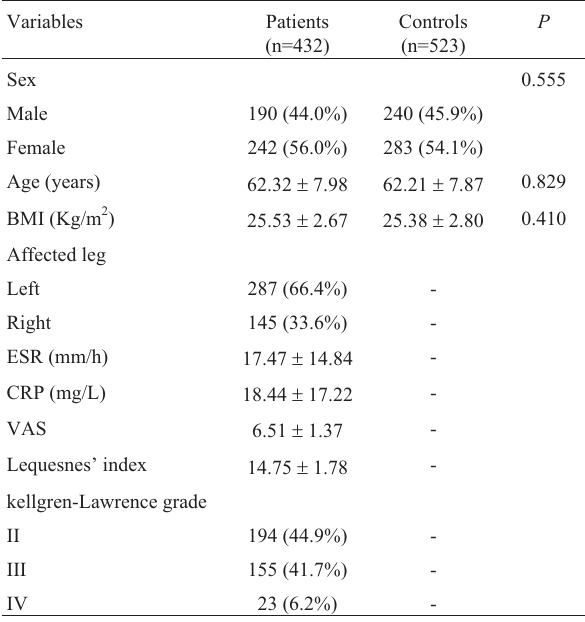
Table 1 - Subjects demographics and risk factors in knee osteoarthritis.